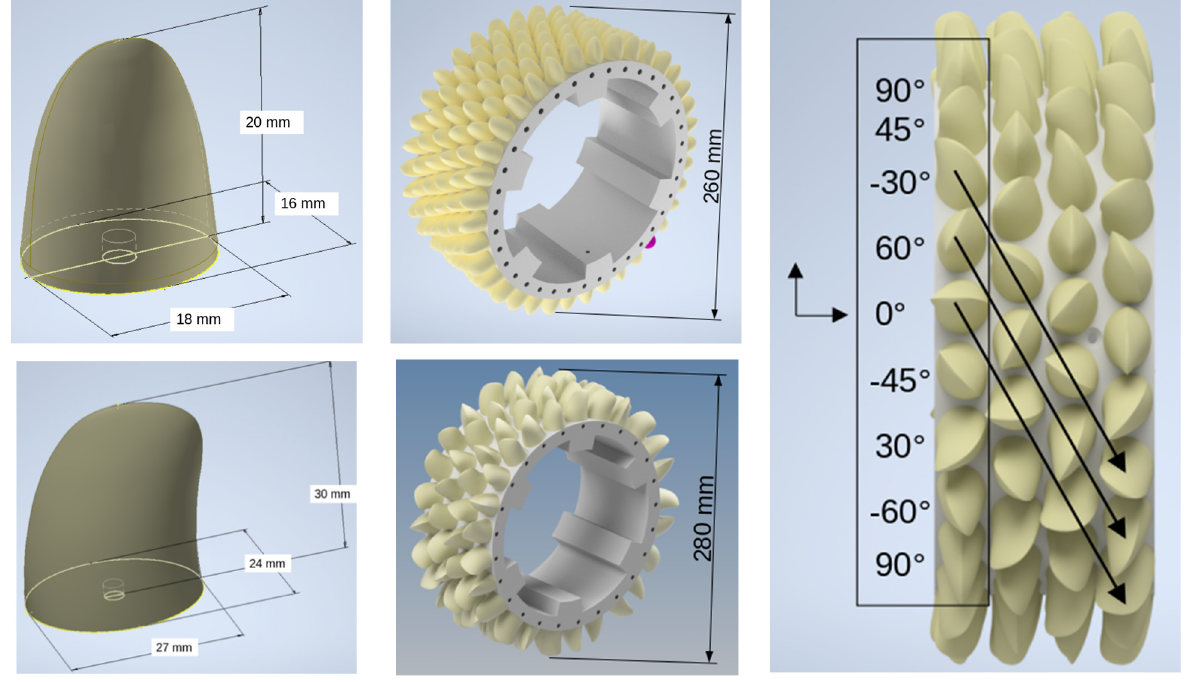
Figure 5. Mussels’ roughness shape for C1 on top and C2 at the bottom. On the right, mussels distribution around the cylinder with the C2 shape.